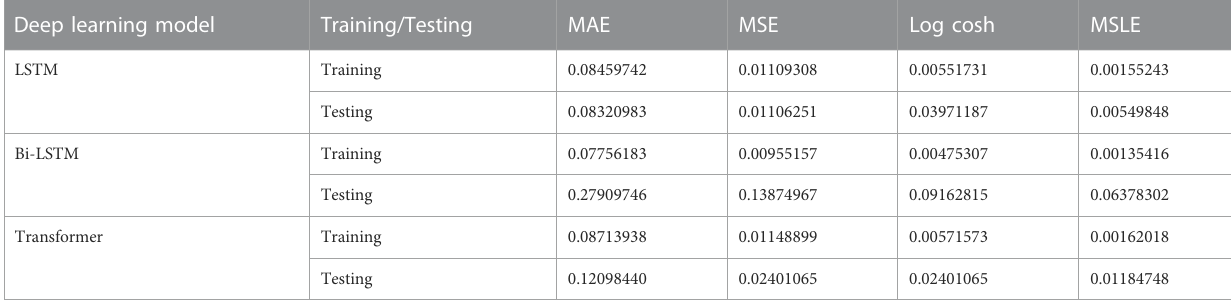
TABLE 4 Results of different models during training and testing using HKKH Region Dataset. Deep learning